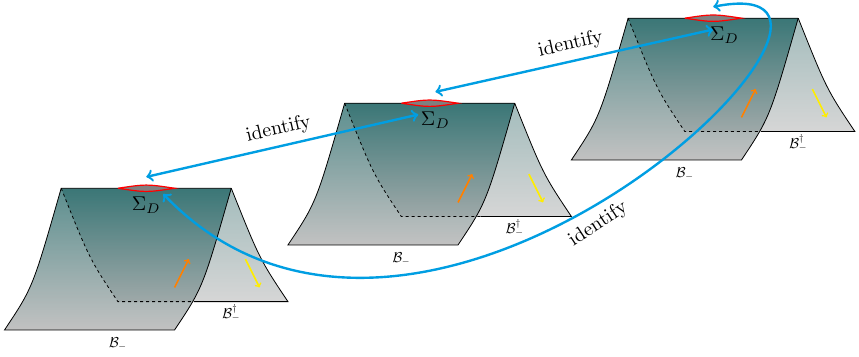
Figure 1 . The manifold B n used compute the path integral for Tr[( ρ ( D )) n ] in a non-gravitating QFT. Here Σ D is a Cauchy surface of D and the figure shows n = 3